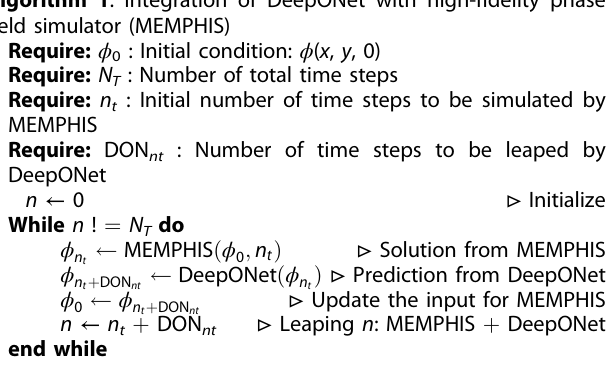
Algorithm 1 . Integration of DeepONet with high- fi delity phase fi eld simulator (MEMPHIS)